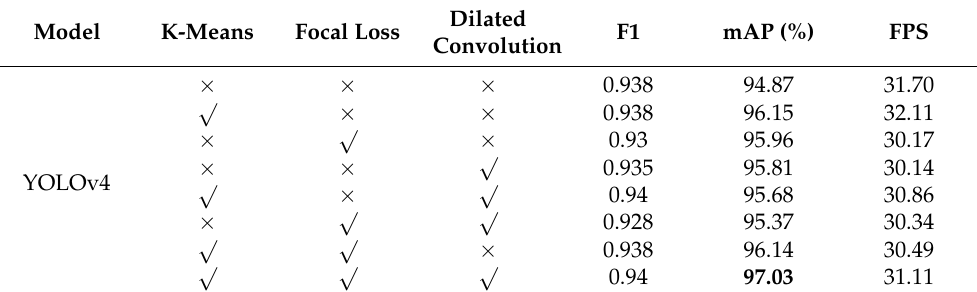
Table 2. Comparison of the mAP of the model under different improvement